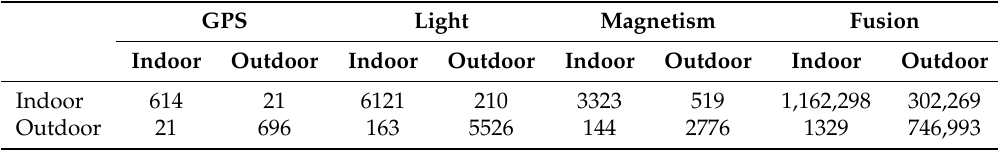
Table 4. Confusion matrix of Building I.